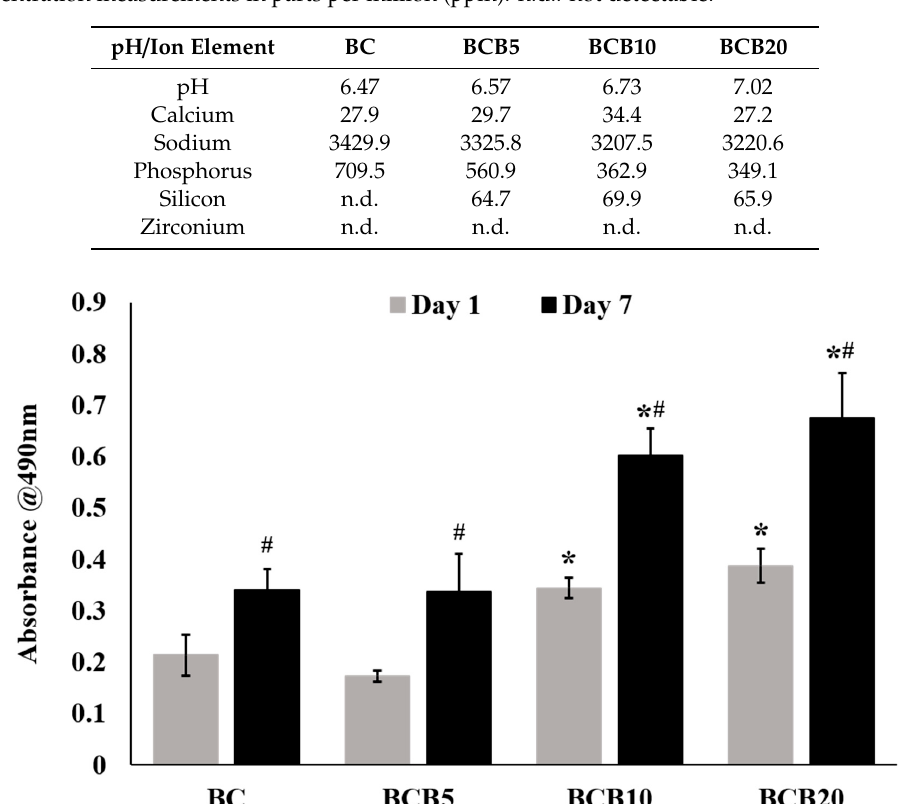
Figure 7. MTS assay absorbance values recorded for primary human osteoblasts cultured in media conditioned with 200 mg / mL of BC, BCB5, BCB10, and BCB20 after 1 day and 7 days of cell culture. #: p < 0.05 vs day 1 absorbance values of the corresponding material; *: p < 0.05 vs BC and BCB5 at the corresponding cell culture time point.